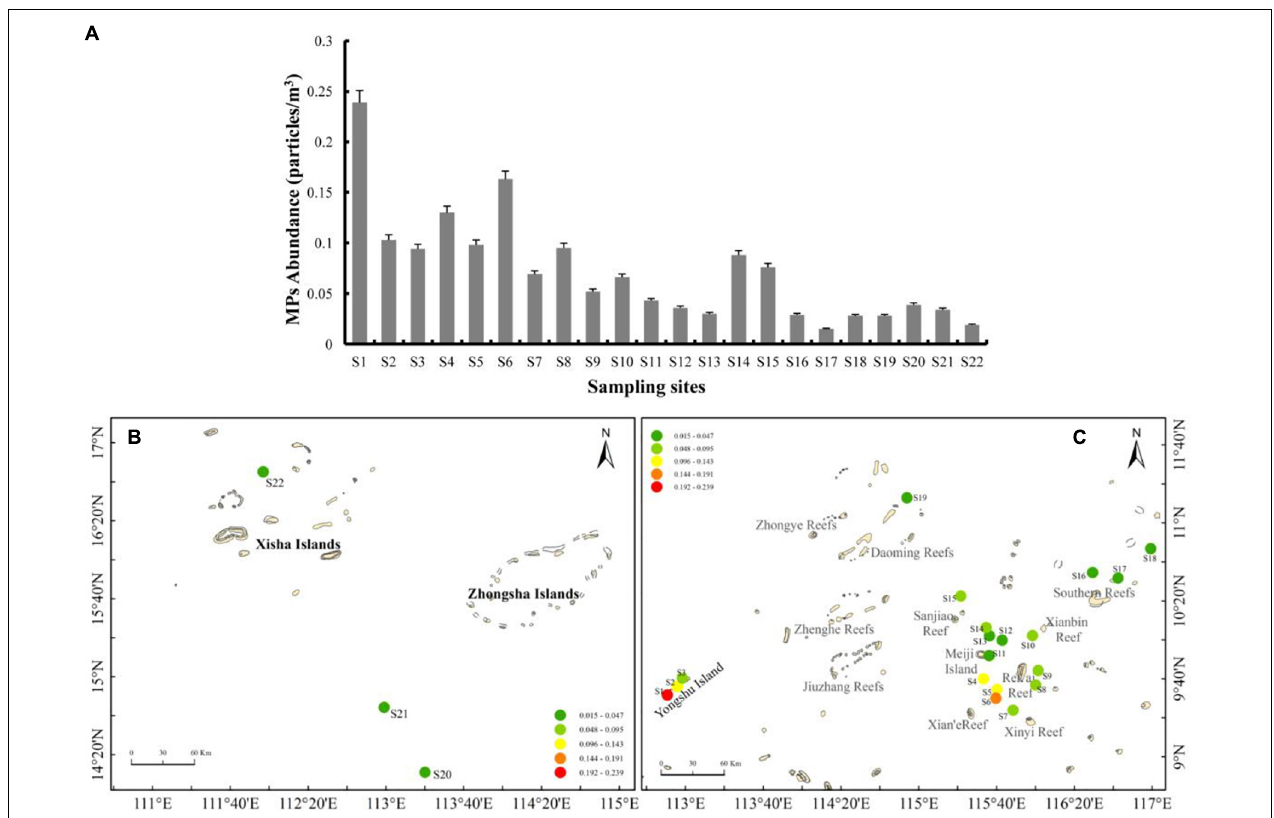
FIGURE 2 | (A) Abundance of surface microplastics (MPs) in the sampling sites around the southwestern SCS. (B,C) Spatial distribution of MPs abundances in the surface water surrounding southwestern